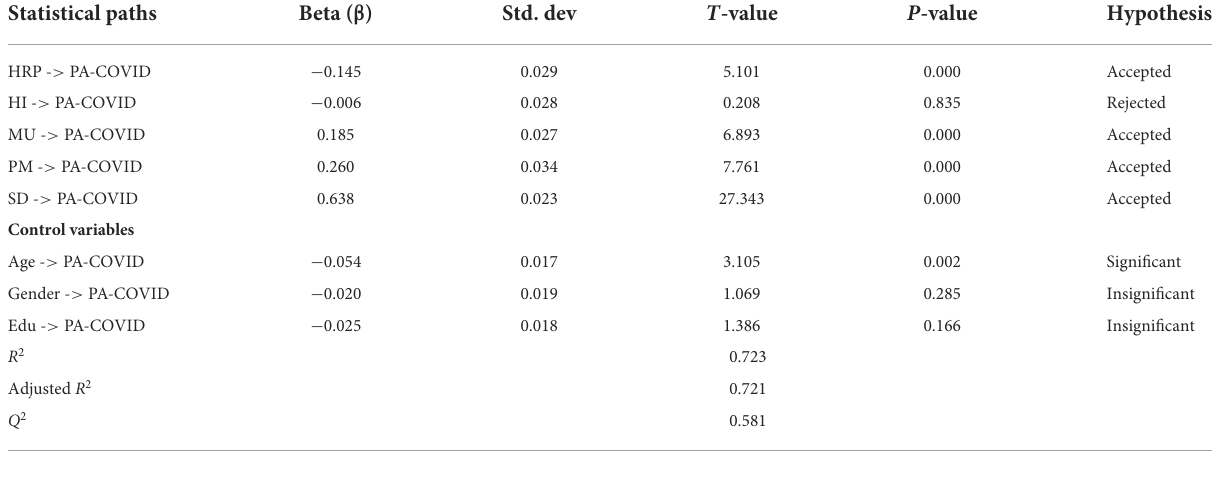
TABLE 4 Path analysis (PLS-SEM).